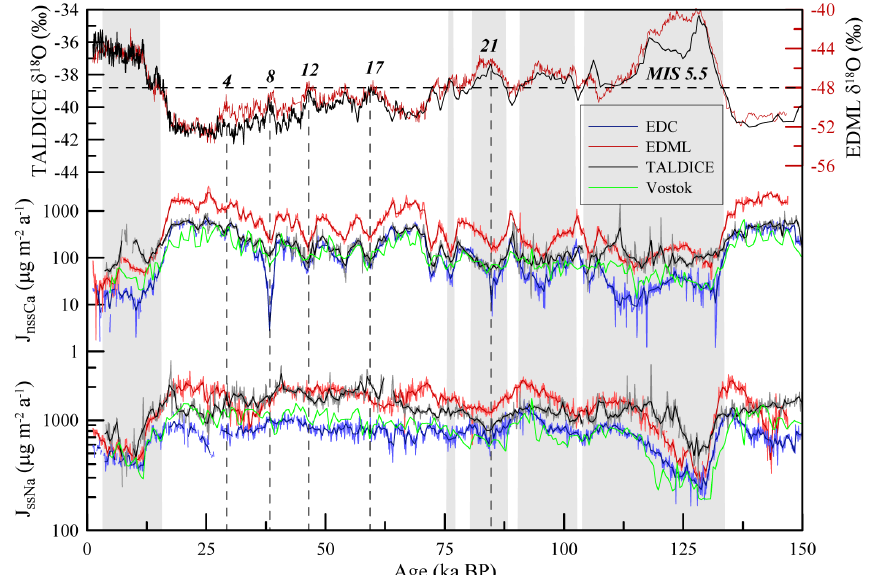
Fig. 3. Top panel: the δ 18 O ice profile of TALDICE (Stenni et al., 2011) and EDML (EPICA, 2006) are shown to illustrate the temperature evolution at the two drill sites. The dashed horizontal line indicates the TALDICE temperature threshold ( δ 18 O ice = − 38.9‰) used to discriminate warm and cold periods, (see text for explanation). Accordingly, the grey shadowed areas indicate warm periods ( δ 18 O ice above threshold). Major AIM events (EPICA, 2006) are indicated by numbers above the curve, the dashed vertical lines indicate the maxima of the corresponding AIM events. Middle panel: the nssCa 2 + flux ( J nssCa ) of TALDICE (new CFA data) is plotted in black along the one of EDC (blue) (Bigler et al., 2006), EDML (red) (Kaufmann et al., 2010)), and Vostok (green) (De Angelis et al., 1997). Bottom panel: the ssNa + flux ( J ssNa ) of TALDICE (new data) is plotted in black along the one of EDC (blue) (Bigler et al., 2006), EDML (red, new CFA data), and Vostok (green) (De Angelis et al., 1997). Light colours indicate 100yr median values, dark colours 500yr median values. All data are shown on the AICC2012 age